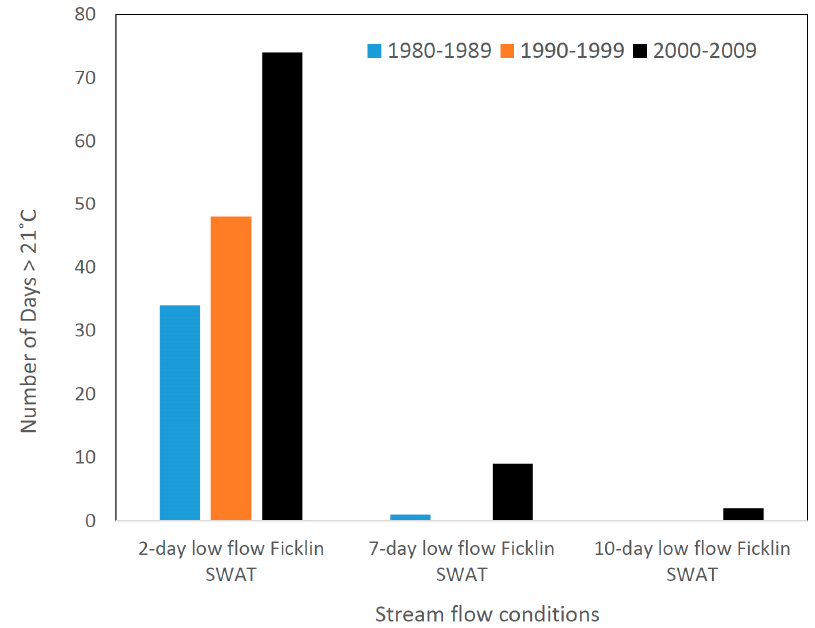
Figure 7. The number of days per decade that stream temperatures exceeded the stress threshold of 21 °C during the 2-, 7- and 10-day moving averages at the lowest 25th flow percentile.